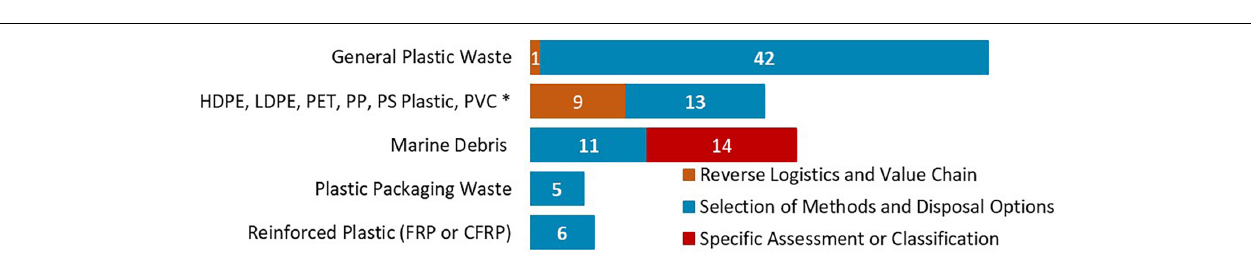
FIGURE 3 | Number of alternatives by plastic type and aim. ∗ HDPE, High-Density PolyEthylene; LDPE, Low-Density PolyEthylene; PET, PolyEthylene Terephthalates; PP, PolyPropylene; PS, PolyStyrene; PVC, PolyVinyl